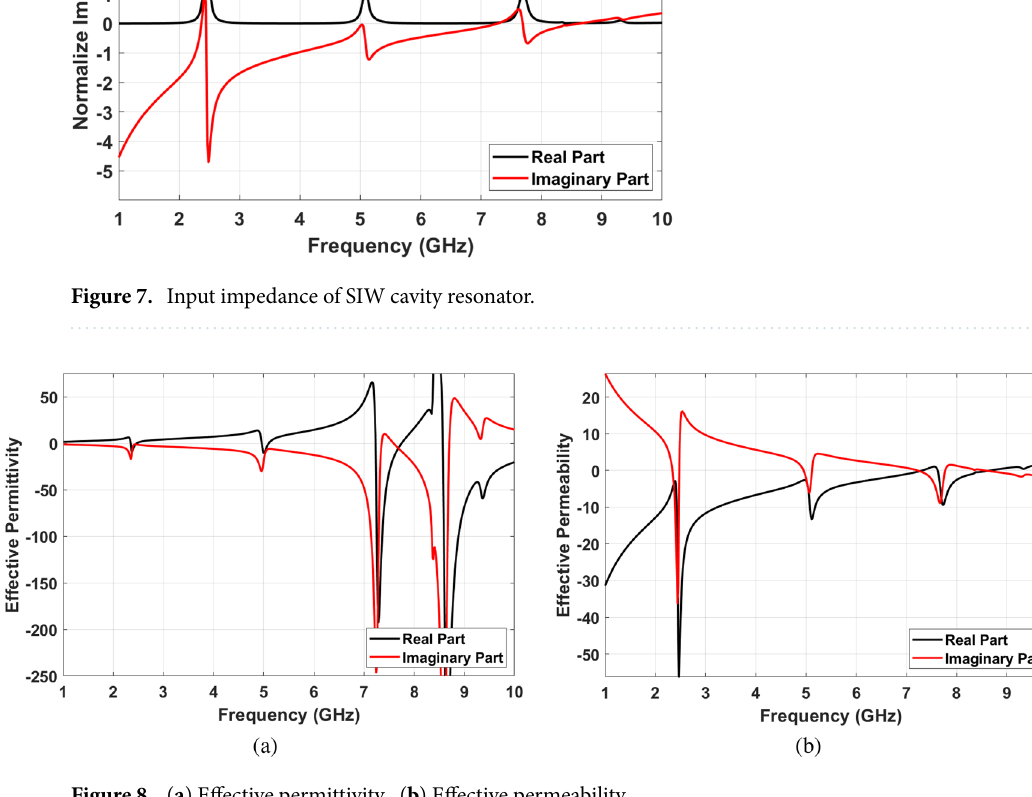
Figure 8. ( a ) Effective permittivity , ( b ) Effective